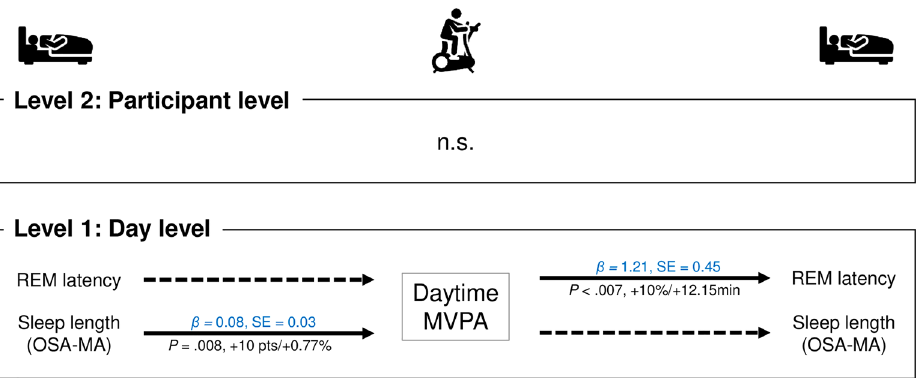
Figure 4. Bidirectional associations between sleep parameters and moderate-to-vigorous-intensity physical activity. Adjusted for age; sex; BMI; history of smoking, alcohol consumption, and caffeine consumption; and medical history of hypertension, hyperlipidemia, and depressive symptoms. MVPA, moderate-to-vigorous- intensity physical activity. The solid line represents significant relevance. A solid line on both sides means that they are bidirectionally related parameters, and a solid line on one side and a dashed line on the other side means that they are only temporally related to each parameter. Blue text means a positive relationship, and red text means a negative